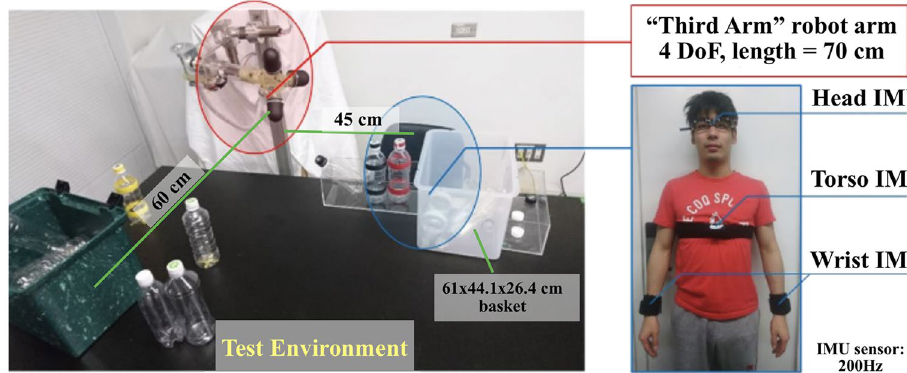
Fig. 11 Experiment